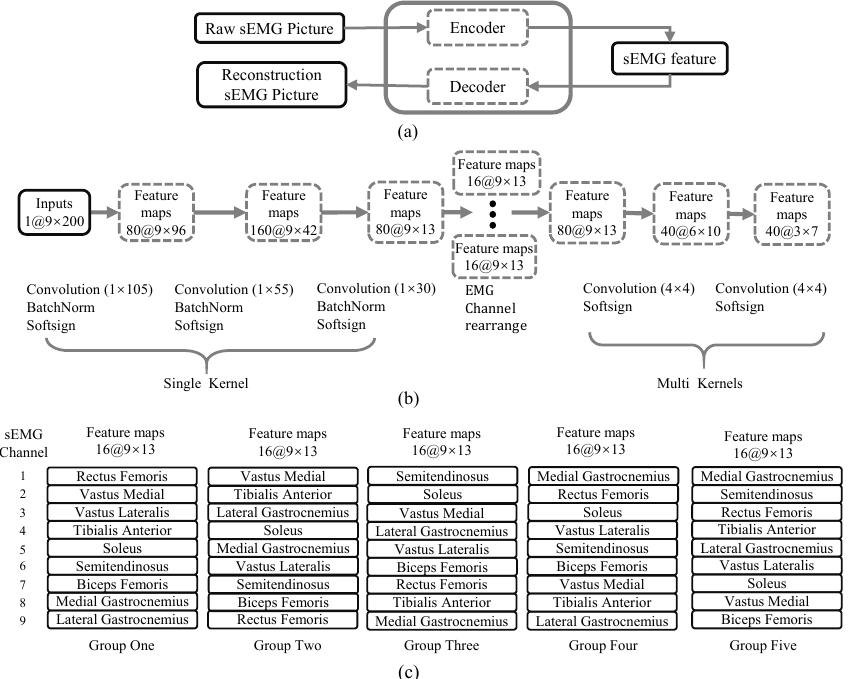
Figure 4. The structure of the feature extraction network. ( a ) Convolutional Auto Encoder; ( b ) The Structure of Encoder; ( c ) The rearrangement of sEMG